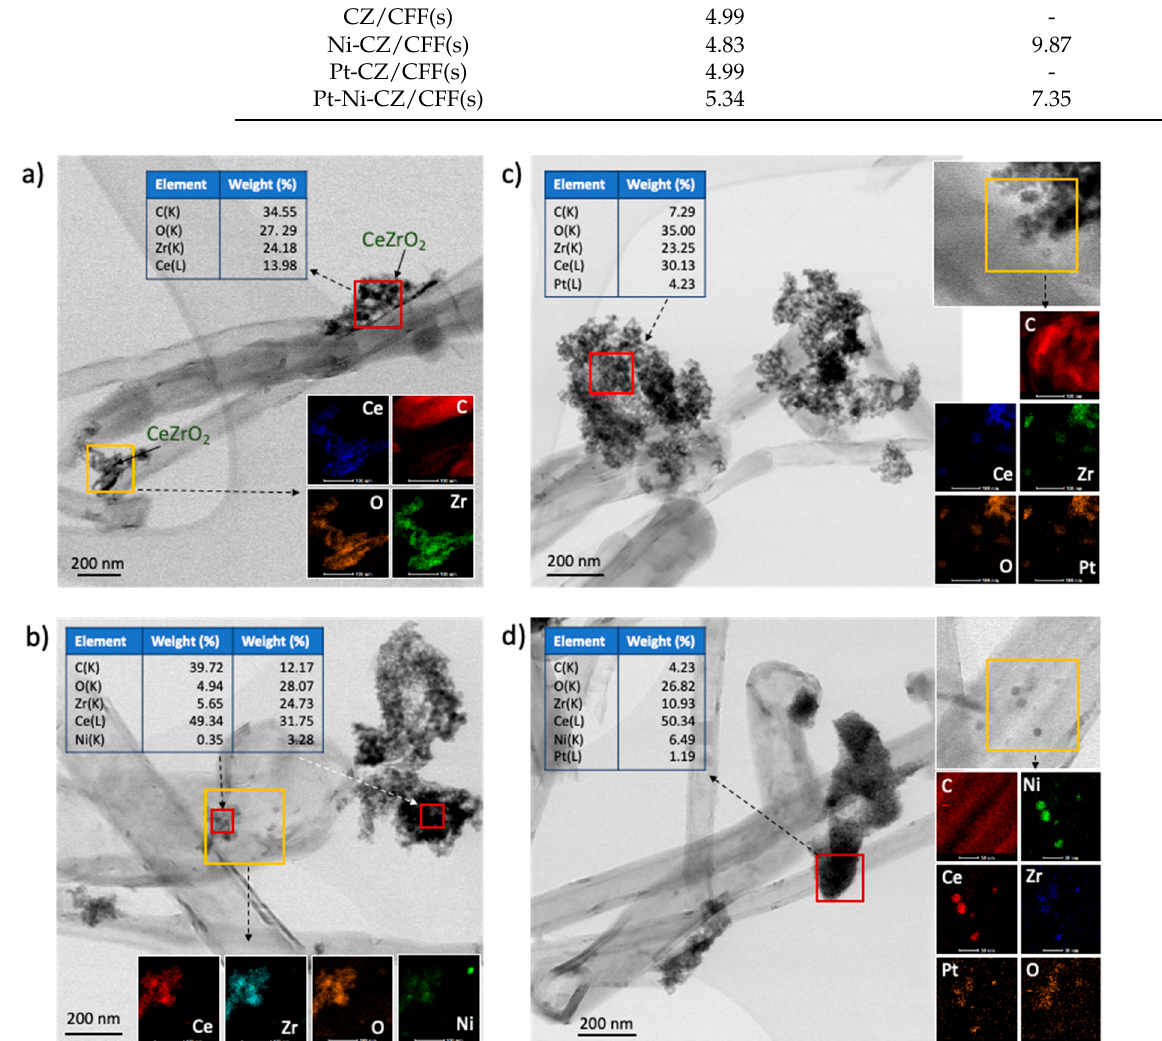
Figure 14. Bright field TEM after DRM: CZ/CFF(s) ( a ), Pt-CZ/CFF(s) ( b ), Ni-CZ/CFF(s) ( c ) and Pt-Ni-CZ/CFF(s) ( d ). Red squares designate the areas of the energy-dispersive spectroscopy (EDS) analyses (results showing catalyst composition are shown in tables). The elemental mapping was performed for the yellow-square areas.